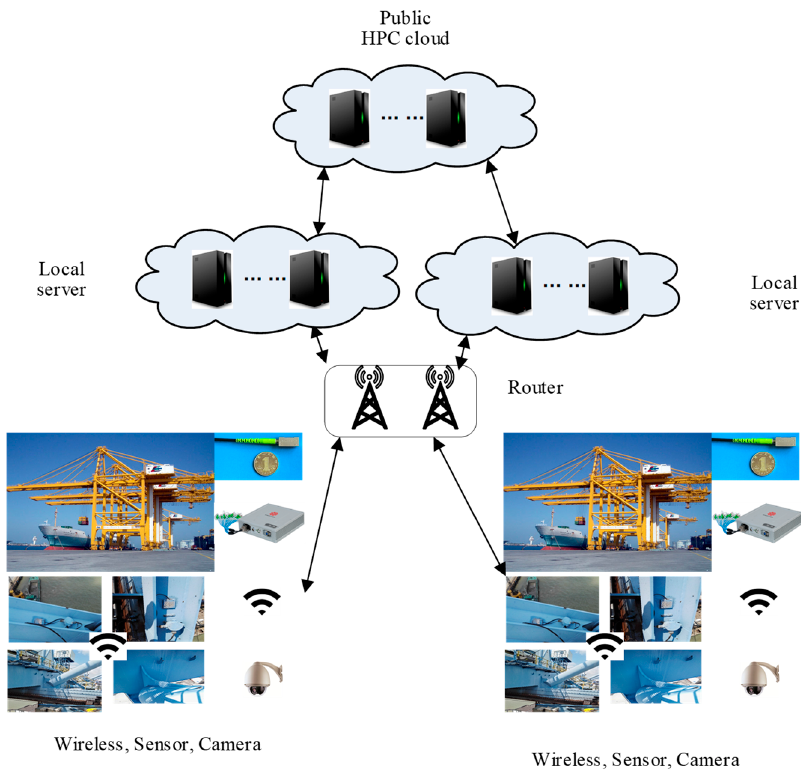
Figure 6. ZigBee wireless network.